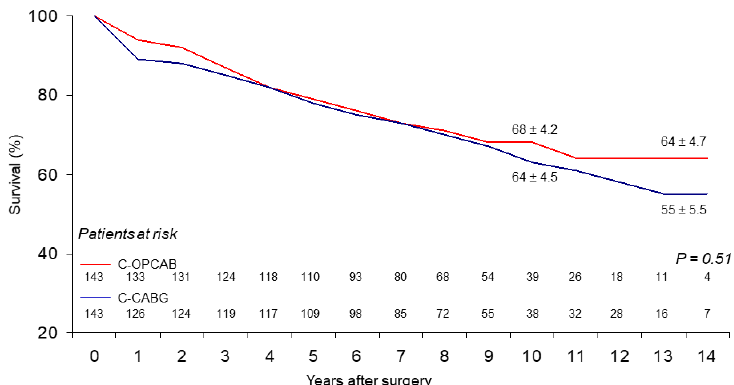
Figure 1. Long-term survival.